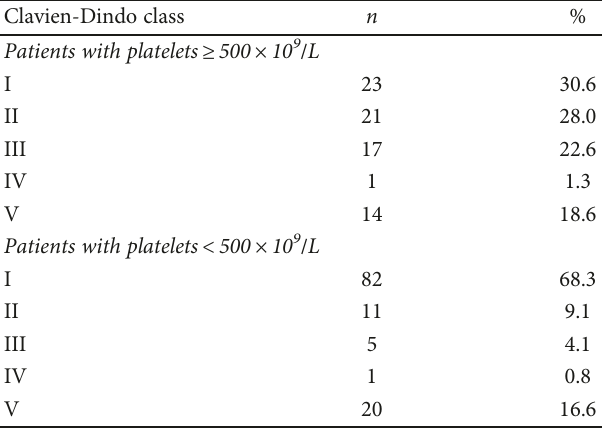
Table 2: Complication rate according to Clavien-Dindo classi fi cation.